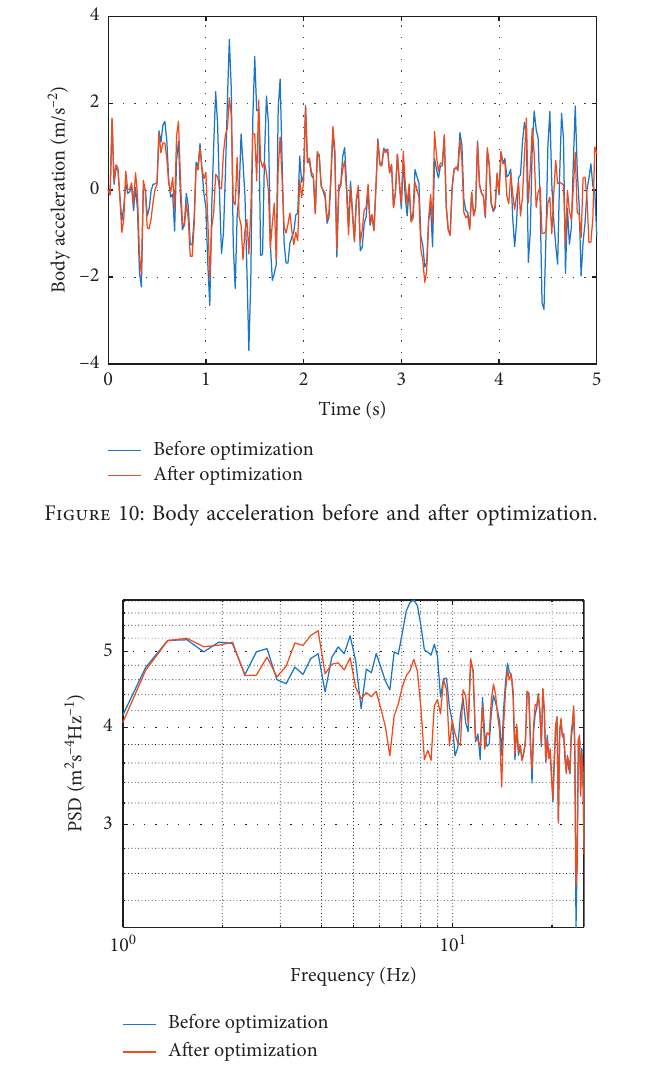
Figure 11: The PSD of the body acceleration before and after optimization.